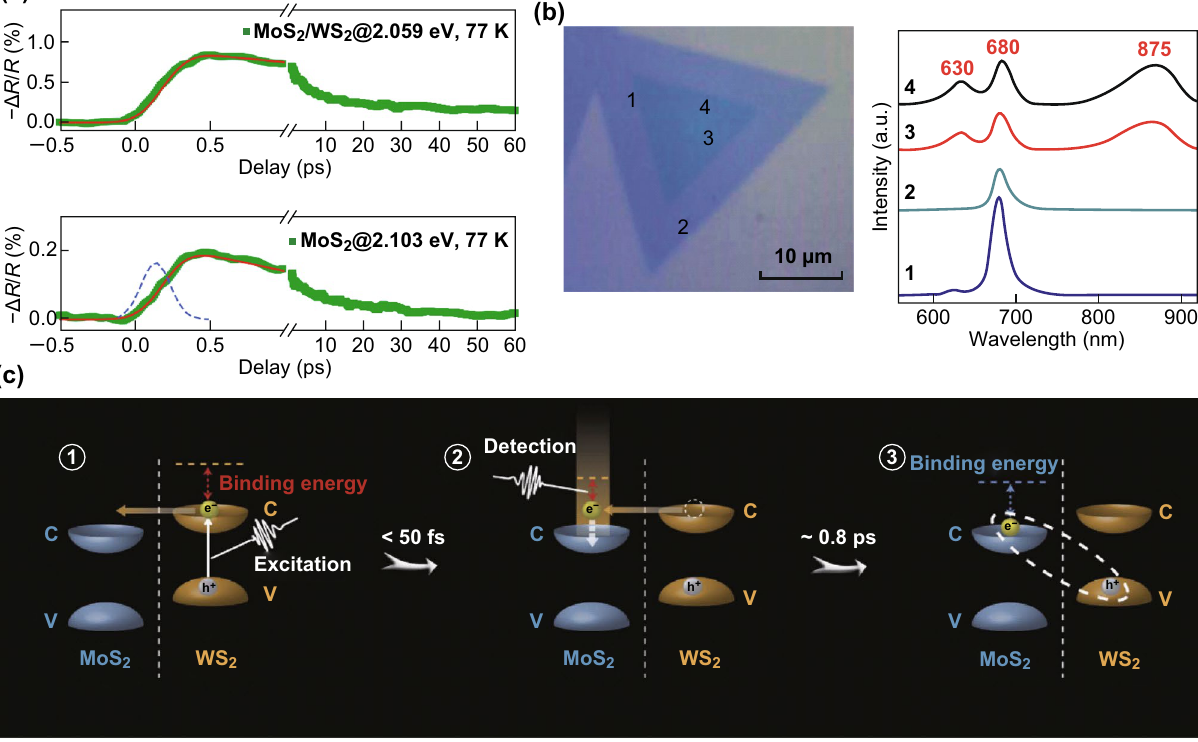
Fig. 5 The generation of interlayer excitons. a The transient absorption measurements of WS 2 A‑exciton resonance in the MoS 2 /WS 2 hetero‑ structure and B‑exciton resonance in an isolated MoS 2 monolayer. The dynamic evolution signal is obtained by convoluting the instrument response function (blue dashed line). b PL spectra detected from the 1–4 region of a vertically stacked WS 2 /MoS 2 heterostructure, and numbers 1 and 2 correspond to the MoS 2 monolayer and number 3 and 4 regions are hetero‑stacked bilayer. Two additional peaks at 630 and 875 nm indi‑ cate the generation of interlayer excitons. Reprinted with permission from Ref. [27]. c The two processes of the interlayer excitons generation. Reprinted with permission from Ref. [62]. (Color figure